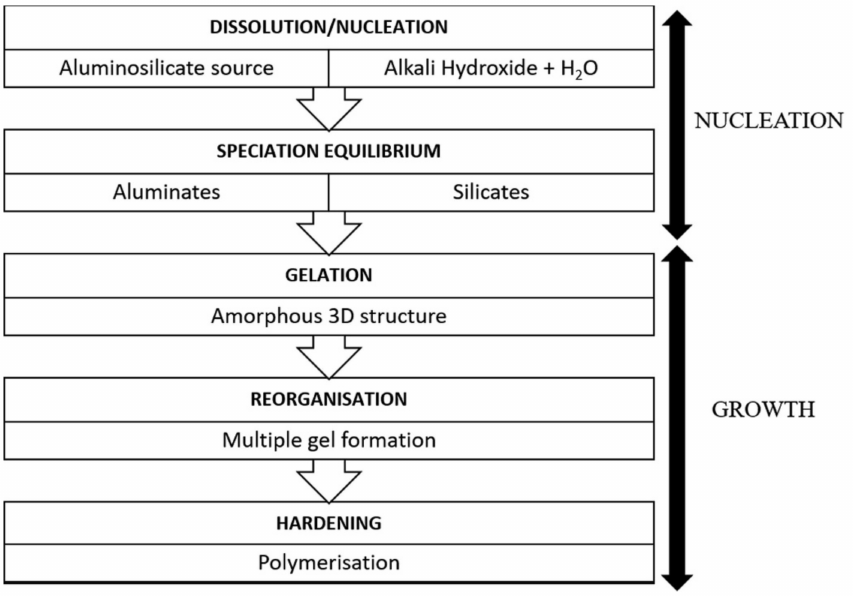
Figure 2. A general flow of geopolymerization process. Reprinted with permission from Ref. [21]. Copyright 2020, with permission from